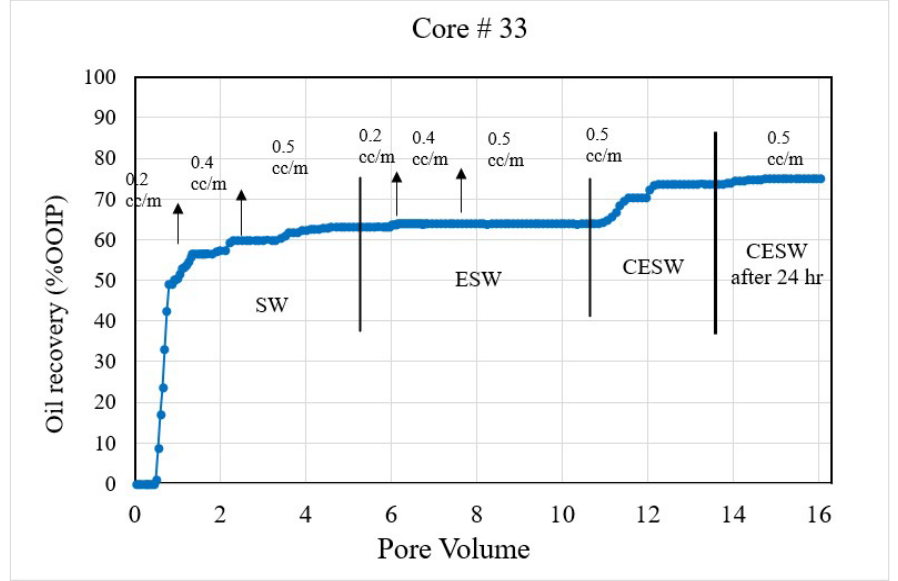
Figure 2. Coreflood with high permeability core plug (K = 20.25 mD). (CF-1 conducted on core plug #33).